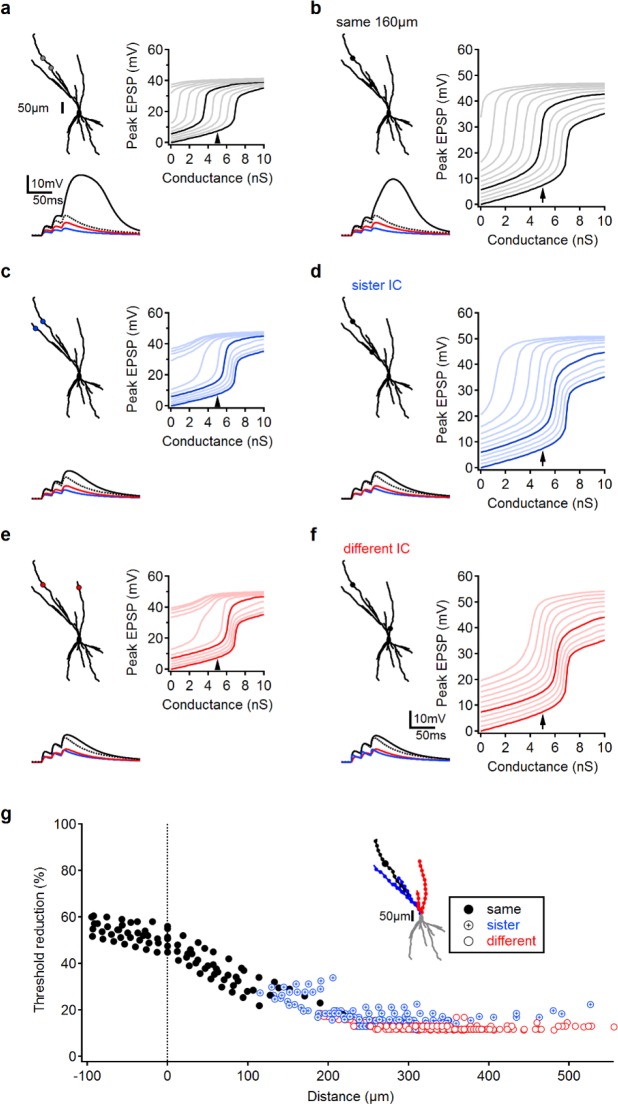
Pairing LOT and IC inputs: modeling results.(a-f) Example paring of a glutamatergic synaptic input on a distal apical branch (control) and a bias input located on the same branch (a, b), sister branch (c, d) or ‘different’ dendrite (i.e. that do not share a primary branch, (e, f). Left, top – morphology of the reconstructed cell and stimulation locations. Left, bottom, example paring; red – somatic EPSP following activation of 5 nS control input; blue, EPSP following activation of a 4 nS bias, this bias level was selected to produce ~5 mV depolarization at the soma and ~50% reduction in NMDA spike threshold for paring of nearby inputs, similar to experimental conditions. Black, combined activation of bias and control synapses. Dotted line, the expected linear summation of the two individual inputs. Right, peak somatic EPSP amplitudes for progressively increasing stimulation intensities of the control input. Right bold trace – in the absence of bias, lighter traces – simulations in the presence of a bias input; traces differ by the magnitude of the bias intensity (left bold trace, bias of 4 nS). Arrow indicated the stimulation intensity of the control input used to produce the left, bottom plots. (g) Reduction in spike threshold between control activation only and pairing of control with 4 nS bias inputs as a function of distance between the two stimulation locations. Data from six different control locations in three reconstructed cells. Inset, schematic locations of the bias input color coded by same/sister/different dendrites, location of the control input is as in (a-f); also depicted here by the large circle.